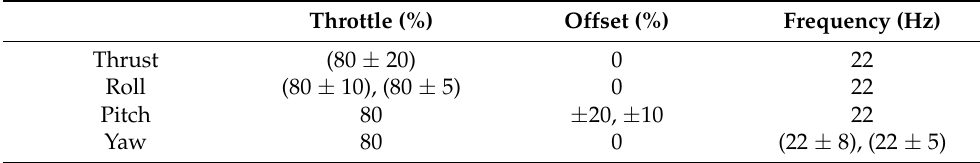
Table 2. Test control inputs for throttle, roll, pitch, and yaw